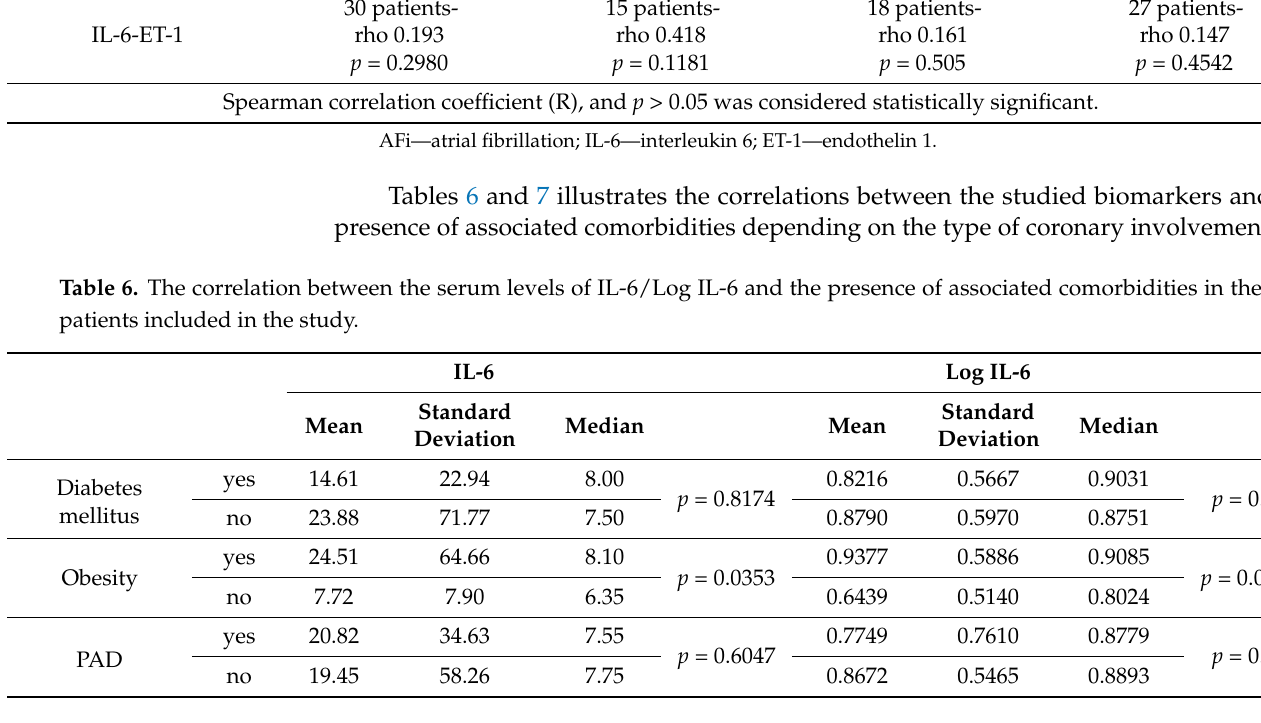
with AFi without AFi